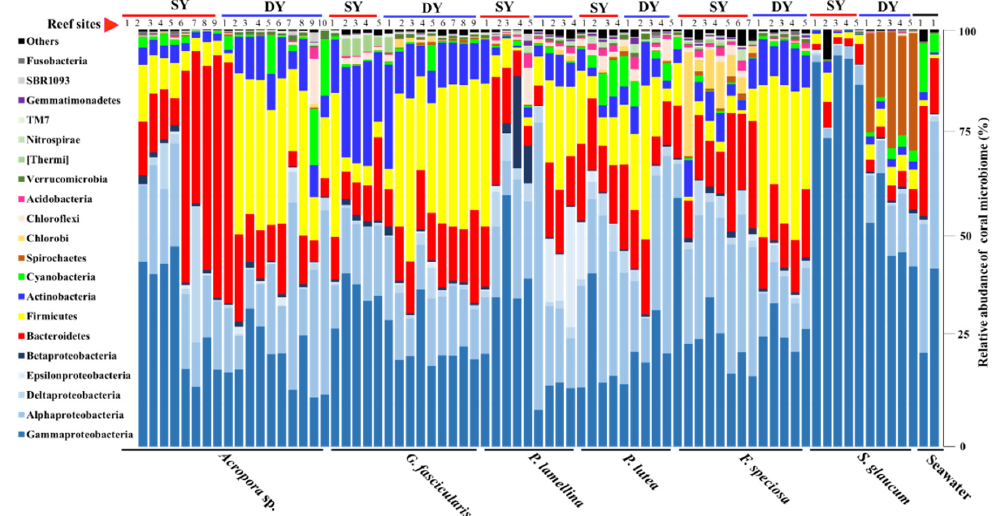
Figure 4. Bar plot of the relative abundance of coral microbiome at the phylum level. Each bar represents the relative abundance of di ff erent bacterial phylum in coral microbiomes or seawater